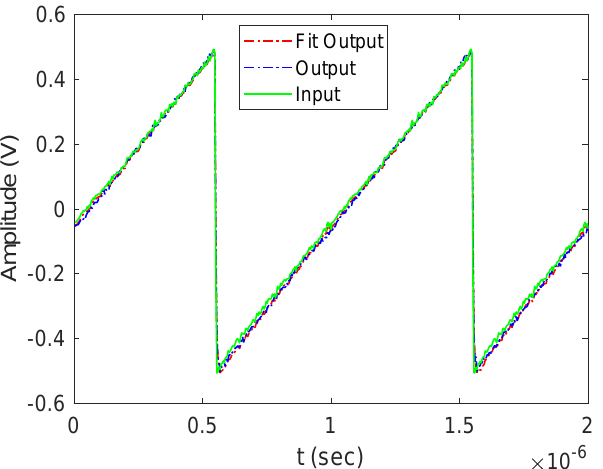
Figure 14. Measured and fitted sawtooth response with only one transformer, γ = 1 and R IN = ∞ in Figure 8 and Equation (9), superimposed onto a 1 MHz input signal. Fitted and measured signals are indistinguishable. Signals are normalized in